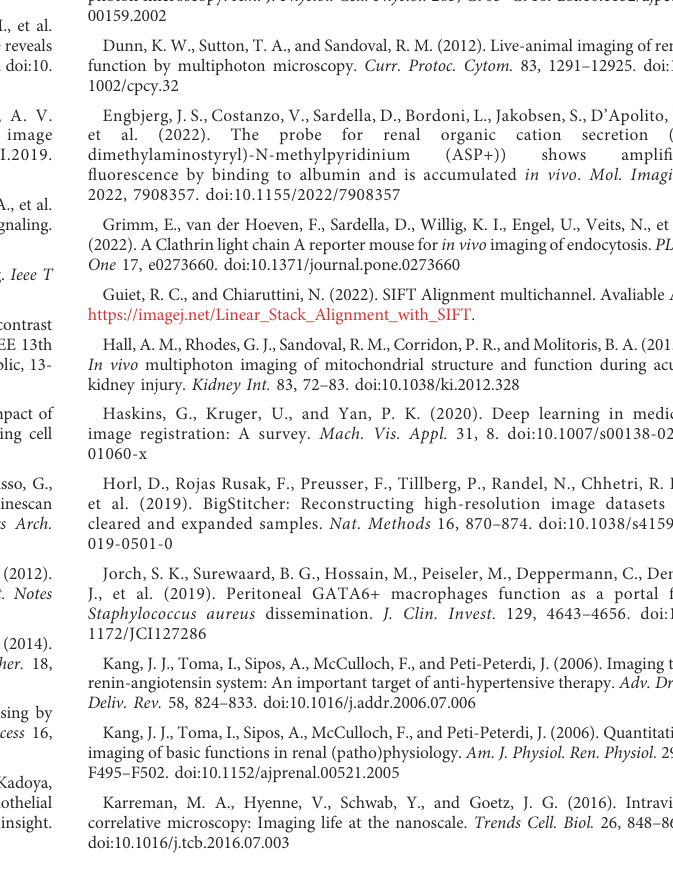
SUPPLEMENTARY FIGURE S1 Performance of multiple denoising algorithms on individual detection channels of the validation dataset. (A – C) : Representative intravital 2 photon microscopy collages showing raw data (Raw, top left), the N2V3D-denoisedimage(topright)andrespectivegroundtruthimage(GT, bottom)fordetectionchannel1(Ch1,A),channel2(Ch2,B)andchannel3